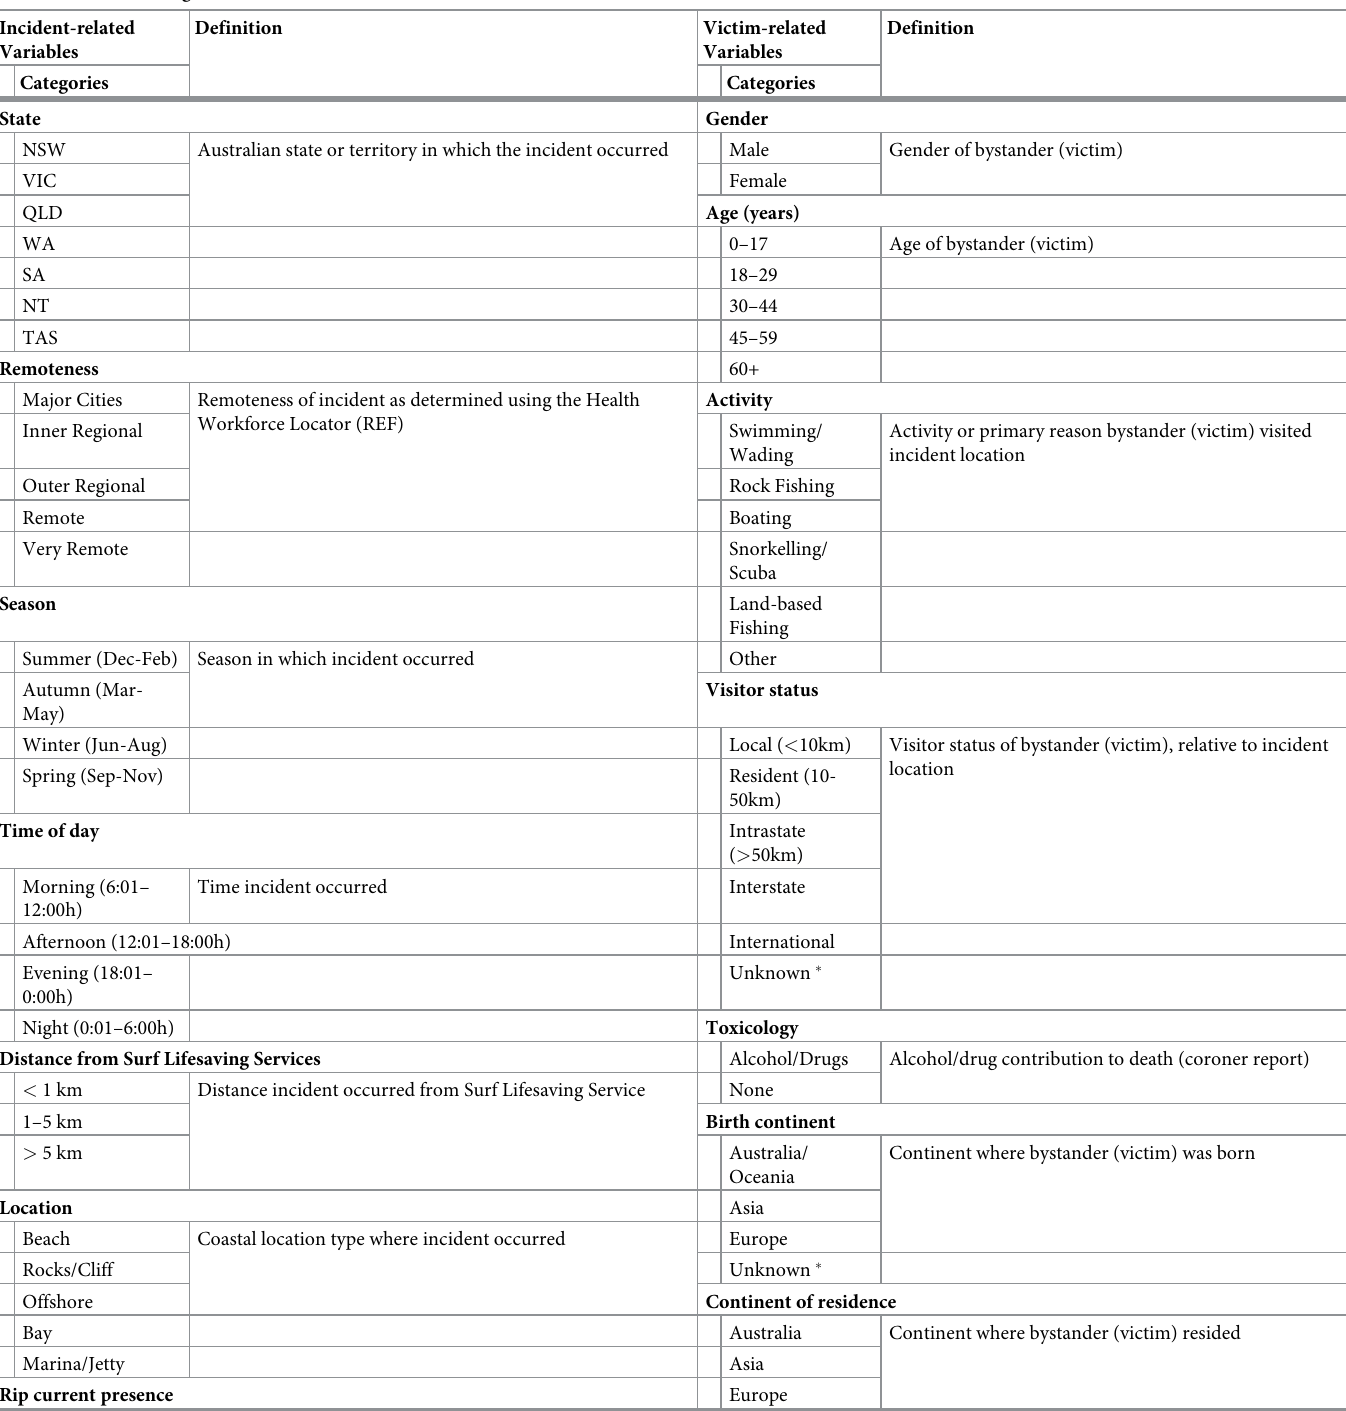
Table 1. Variable categorisation and